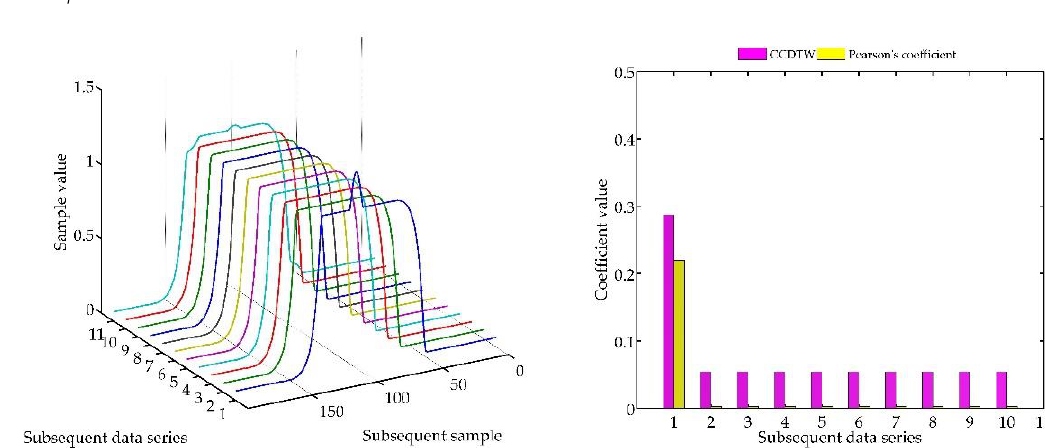
Figure 16. Simulation results achieved for data shifted by − 10 samples for the first series (blue line) for r ampl = 2.